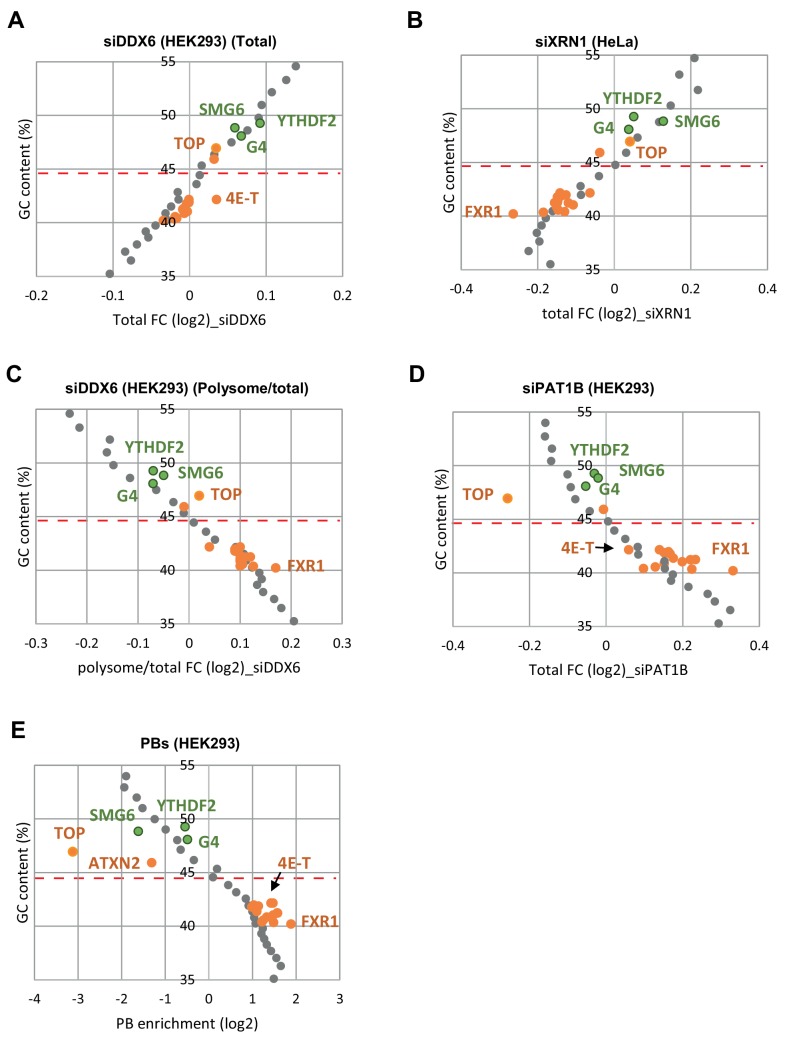
Targets of the group I and II regulators behave like mRNAs of similar GC content.(A–E) The whole transcriptome was binned depending on its GC content (bin size of 500 mRNAs). The median GC content of each bin was represented as a function of its median fold-change in the various datasets (in gray). The same analysis was performed for the targets of group I (in green) and II (in orange) regulators, and superimposed to the graphs. The dashed line indicates the median GC content for all mRNAs. Overall, in all datasets, the targets of the different regulators behave similarly to mRNAs of same GC content. For figure clarity, only the few regulators leading to distinct behaviors were indicated.